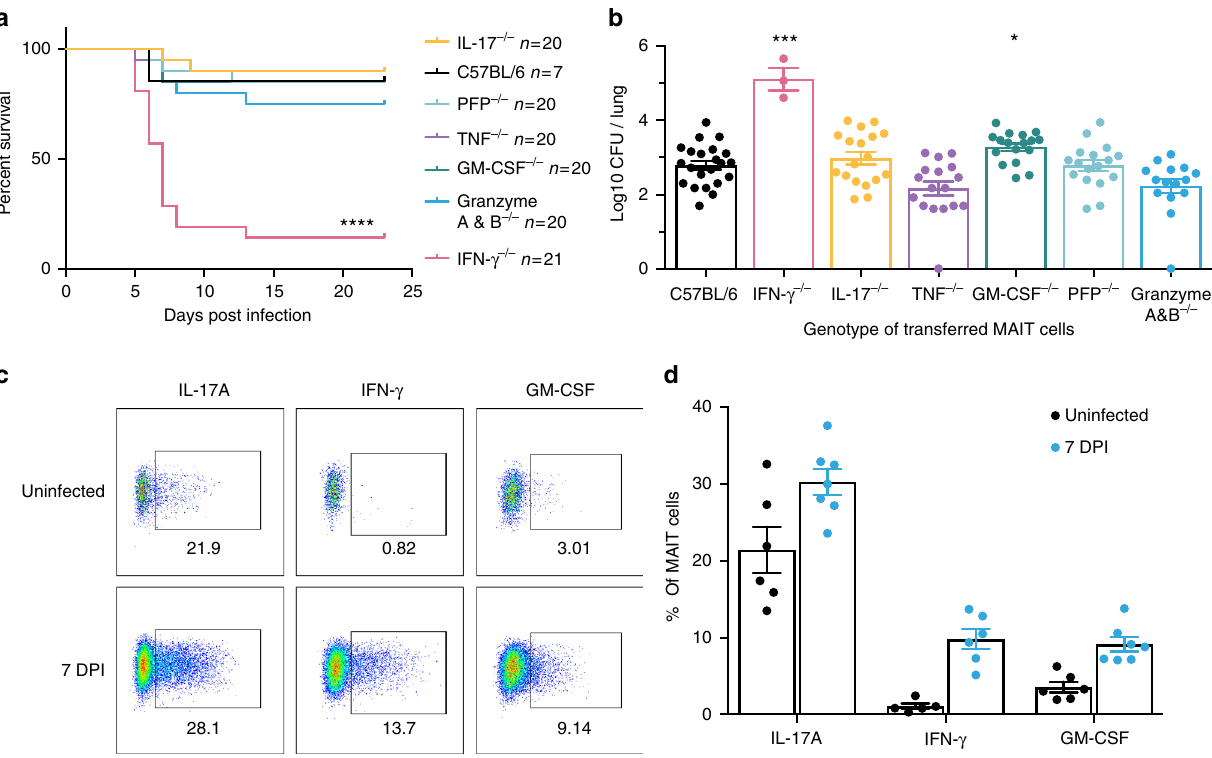
Fig. 8 Protection of Rag2 − / − γ C − / − mice from Legionella is dependent on IFN- γ . a Survival of Rag2 − / − γ C − / − mice adoptively transferred with pulmonary MAIT cells generated from different mouse strains, after 10 4 CFU i.n. L. longbeachae . ****Gehan – Breslow-Wilcoxon P < 0.0001. b Pulmonary bacterial load in surviving Rag2 − / − γ C − / − mice in a 23 DPI. Pooled data (mean ± SEM) from two replicates with similar results, each with 7 – 13 mice per group, except the Ifng − / − MAIT transferred group, in which only 3 mice survived to 23 DPI. c Representative fl ow cytometry plots and d percentages of cytokine expressing transferred MAIT cells by intracellular staining (direct ex vivo) for IL-17A, IFN- γ and GM-CSF from uninfected (top panel) or infected (7 DPI, bottom panel) mice after 4 h of culture with brefeldin A. Percentages in brackets in c represent the proportion of MR1-tetramer-positive MAIT cells expressing cytokine. Data were pooled with 5 – 7 mice per group (mean ± SEM) from two independent experiments. Mean ( b ) is shown. PFP perforin. Bonferroni-corrected t - tests * P < 0.05; *** P <